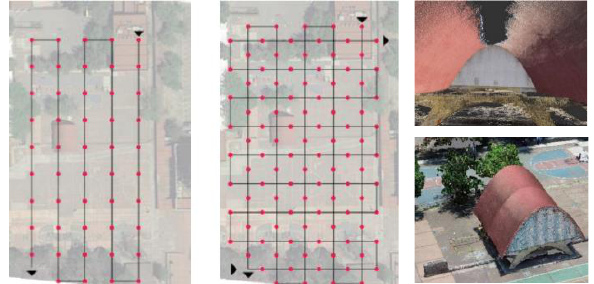
Figure 16. Left: First round of drone movement, red dots are the shots taken. Center : Second Round. Top-Right: Exterior point cloud model before receiving drone information, the top part is missing. Bottom–Right: Exterior point cloud model after receiving drone data. (Produced by Rajabzadeh, 2019)